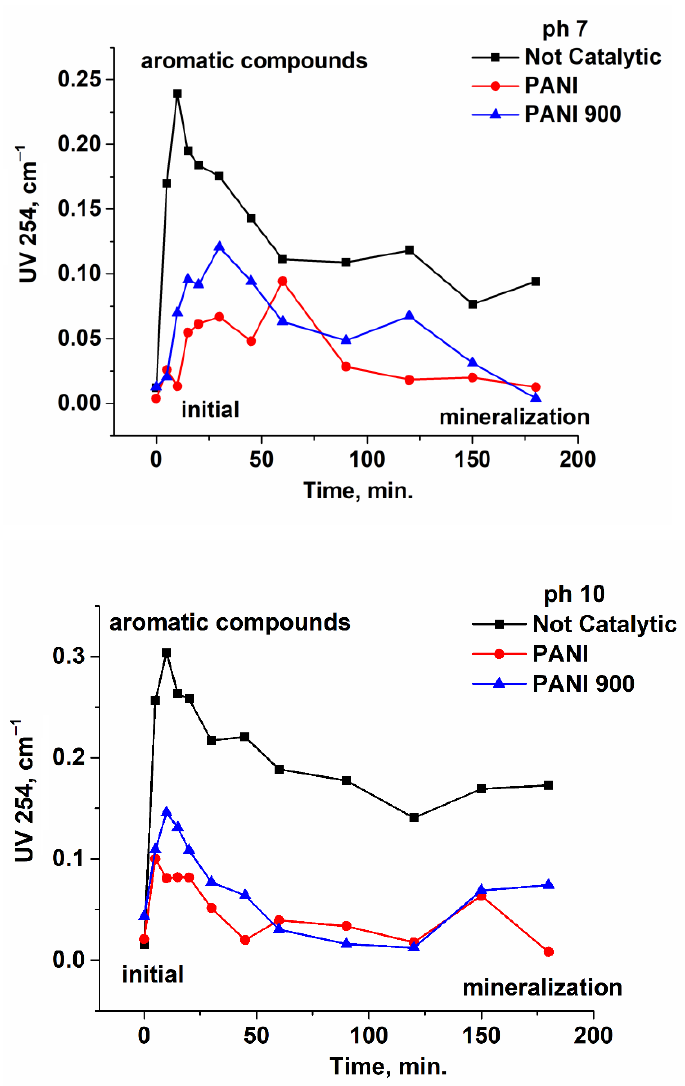
Figure 13. Variation in UV254 absorbance with reaction time at three pH values.